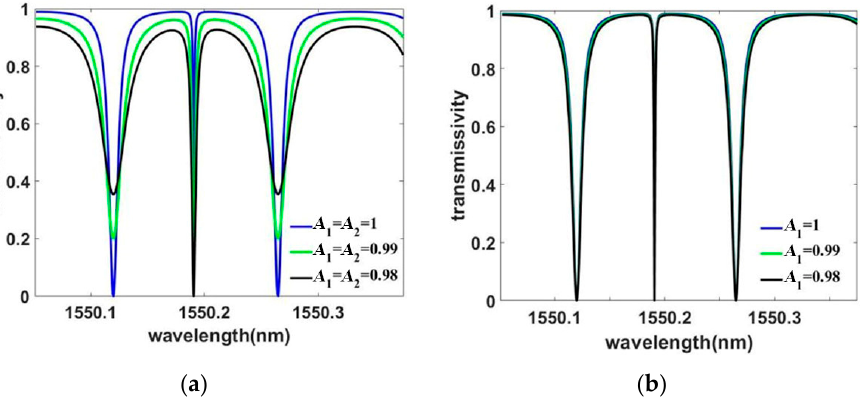
Figure 8. ( a ) The transmissivity of the double ring resonator at di ff erent wavelengths and the fi eld a tt enuation ( 𝐴 (cid:2869) = 𝐴 (cid:2870) ) and ( b ) the transmissivity of the double ring resonator at di ff erent wavelengths and the fi eld a tt enuation of outer ring ( 𝐴 (cid:2869) ). Both are calculated at 𝑡 (cid:2870) = 𝑡 (cid:2871) = 0.9. The resonance peak in the middle is the inner ring resonance peak, and the resonance peak on both sides is the outer ring resonance peak.